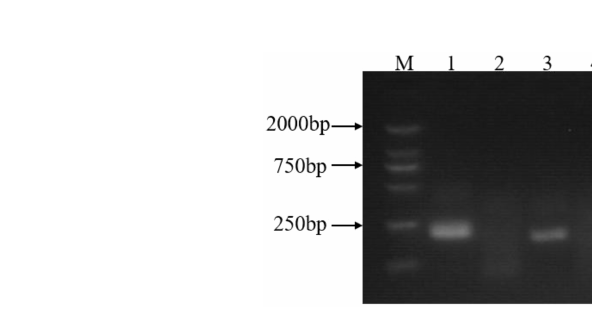
FIGURE 2 Basic-RPA primer screening. Lane1: F1/R1 primers with a 239-bp product; Lane2: no template control for F1/R1 primers; Lane3: F2/R2 primers with a 197-bp product; Lane4: no template control for F2/R2 primers; Lane5: F3/R3 primers, with a 184-bp product; Lane6: no template control for F3/R3 primers; Lane7: F4/R4 primers, with a 187-bp product; Lane8: no template control for F4/R4 primers; M: 2000 bp molecular